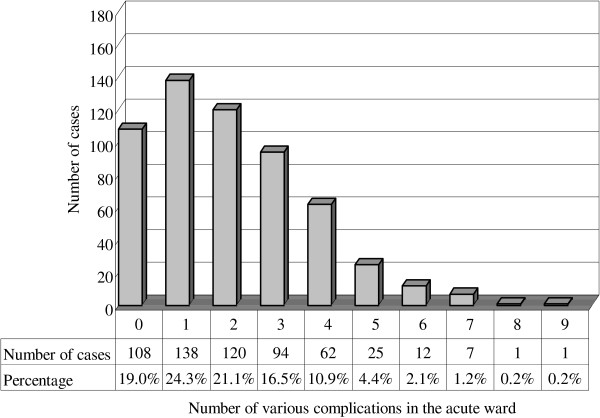
The number of cases and various complications in the acute ward. The numbers on the X-axis correspond to the following: 0 = the sum of the complication types is zero, 1 = the sum of the complication types is one, and so on. The major numbers of various complications in the acute ward were 0, 1, 2, and 3, resulting from 19.0%, 24.3%, 21.1%, and 16.5% of total patients, respectively.